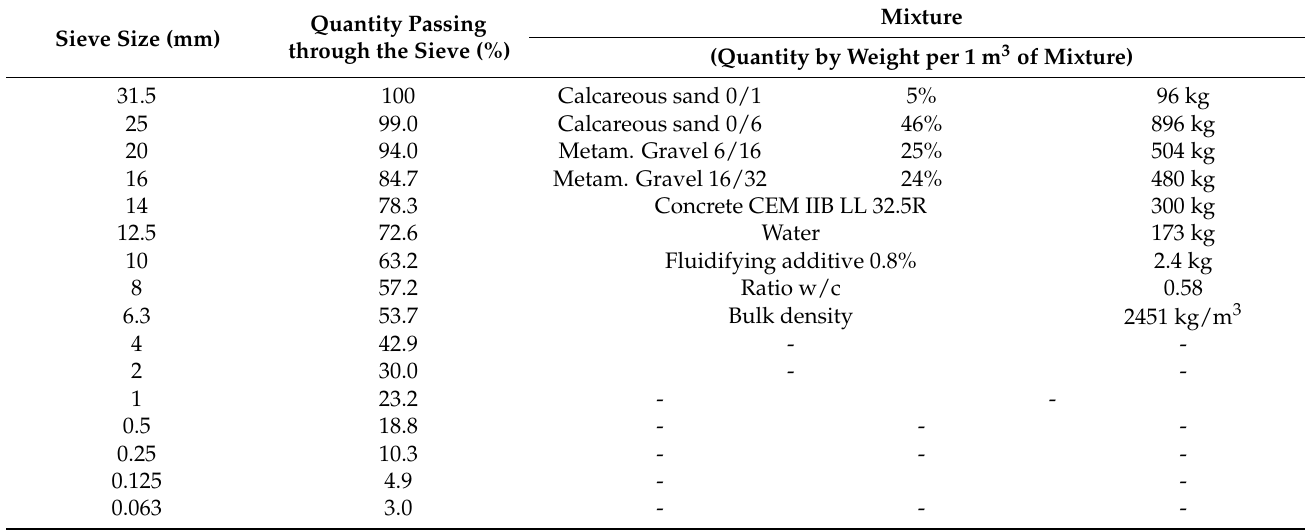
Table 3. Aggregate mixture with metamorphic gravel. On the left side, the quantity passing through the sieve expressed in percentage of the metamorphic gravel and the sieve size used; on the right side, the component used for the mixture. Sieve Size